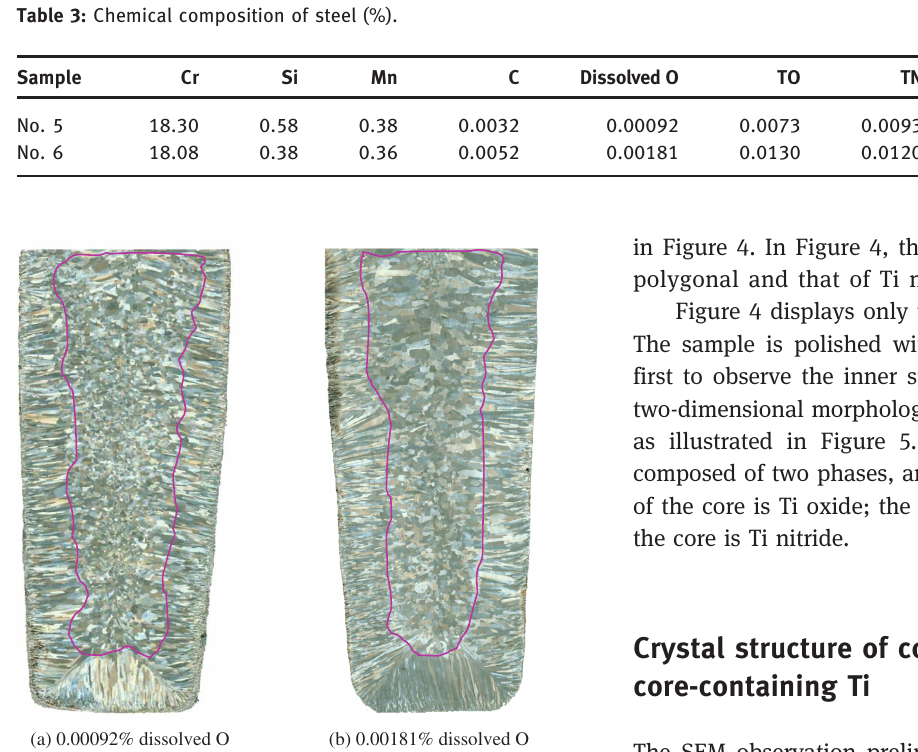
reasonable range to refine the solidification structure.